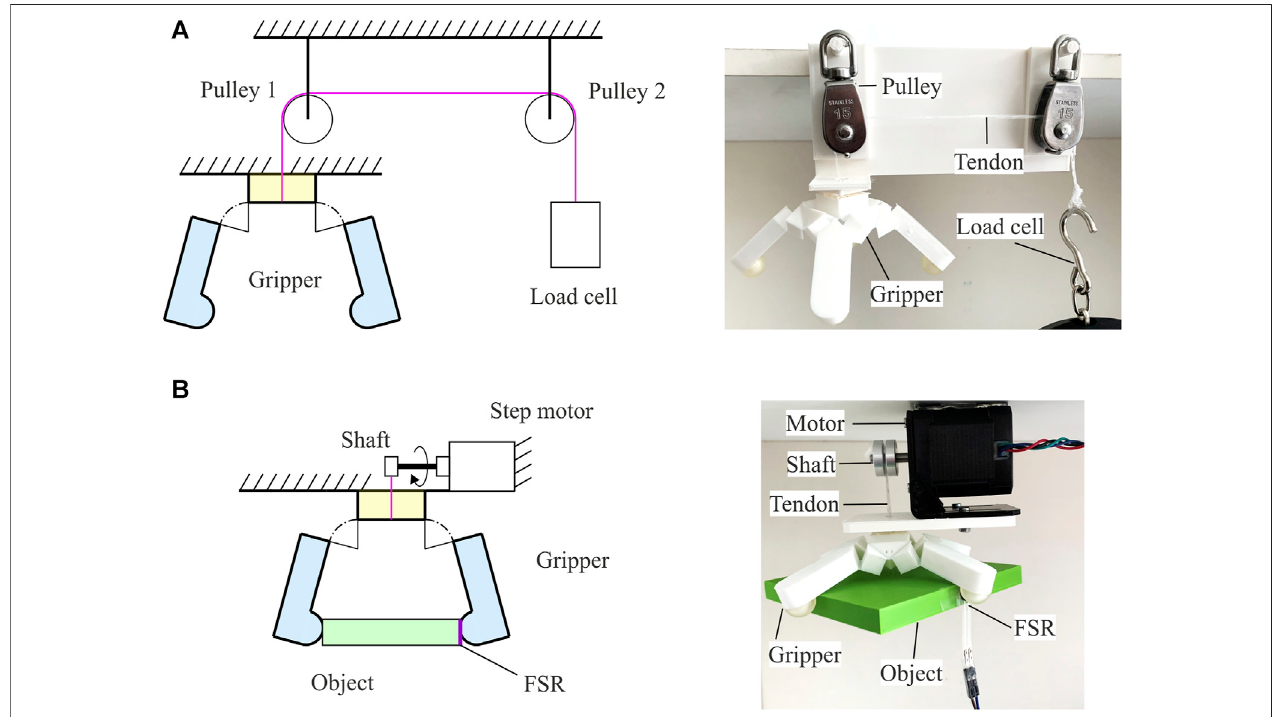
FIGURE6| Experimental setuptomeasure (A) thepullingforce required toclose thegrippertodifferentstates and (B) themaximum contact forcethatthegripper is able to generate on objects of different sizes. Both schematic views and practical settings are displayed.